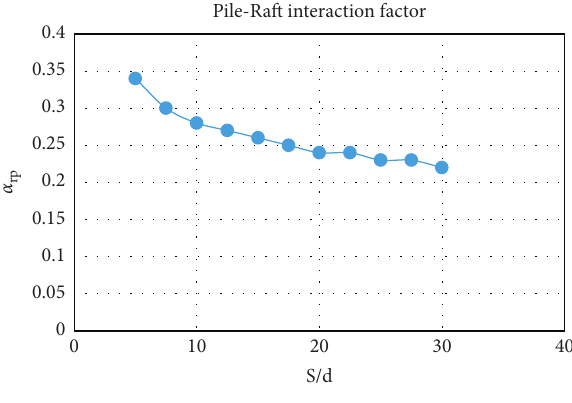
Figure 10: Interaction factor vs. S / d .